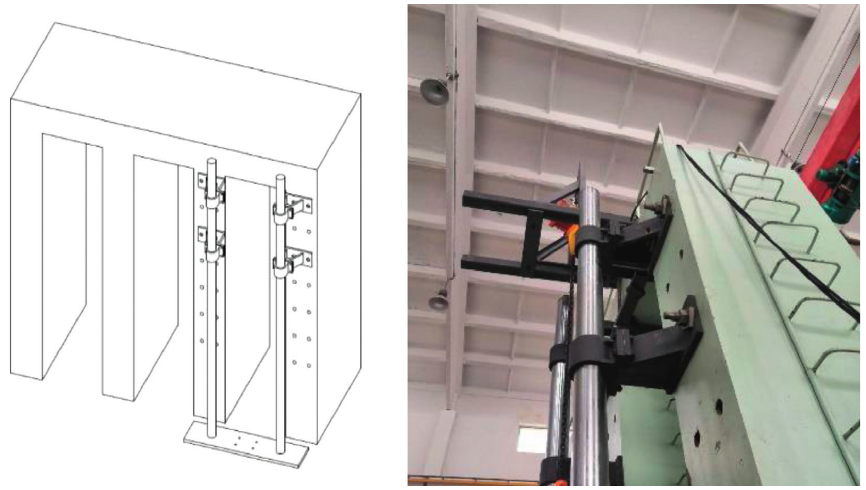
Figure 10: Drop hammer impact testing